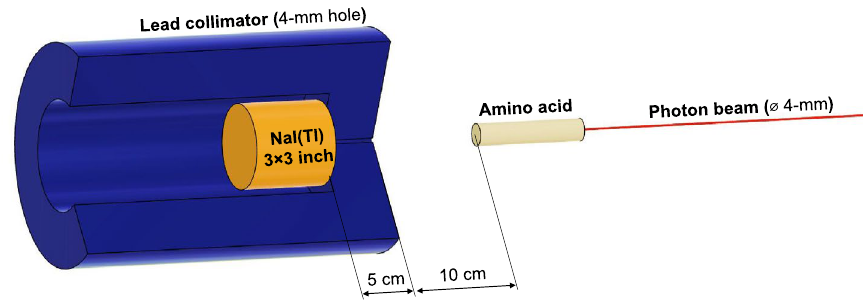
Fig. 1 Narrow beam geometry for PHITS simulations